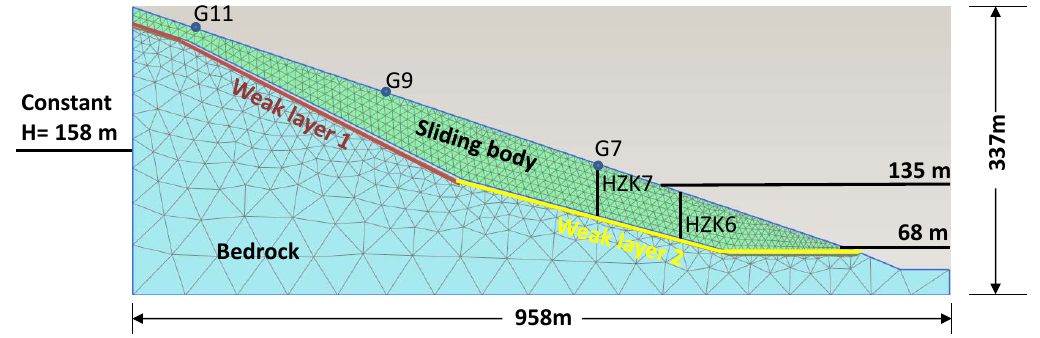
Figure 3. Numerical model geometry and finite element